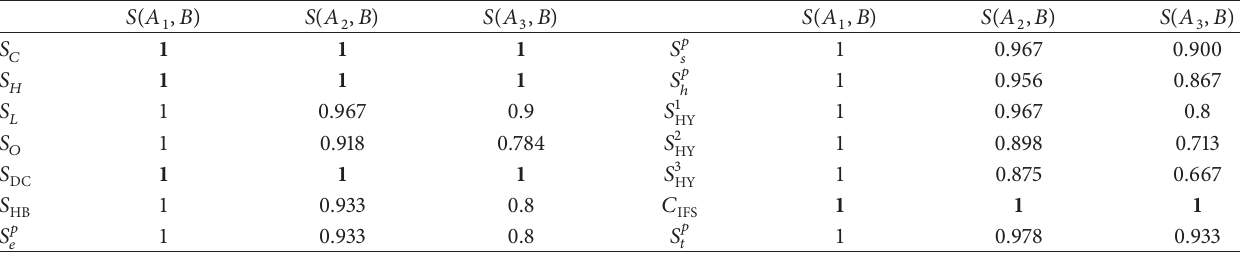
Table 2: The similarity measures between the known patterns and the unknown patterns in Example 9 (patterns not discriminated are in bold type).